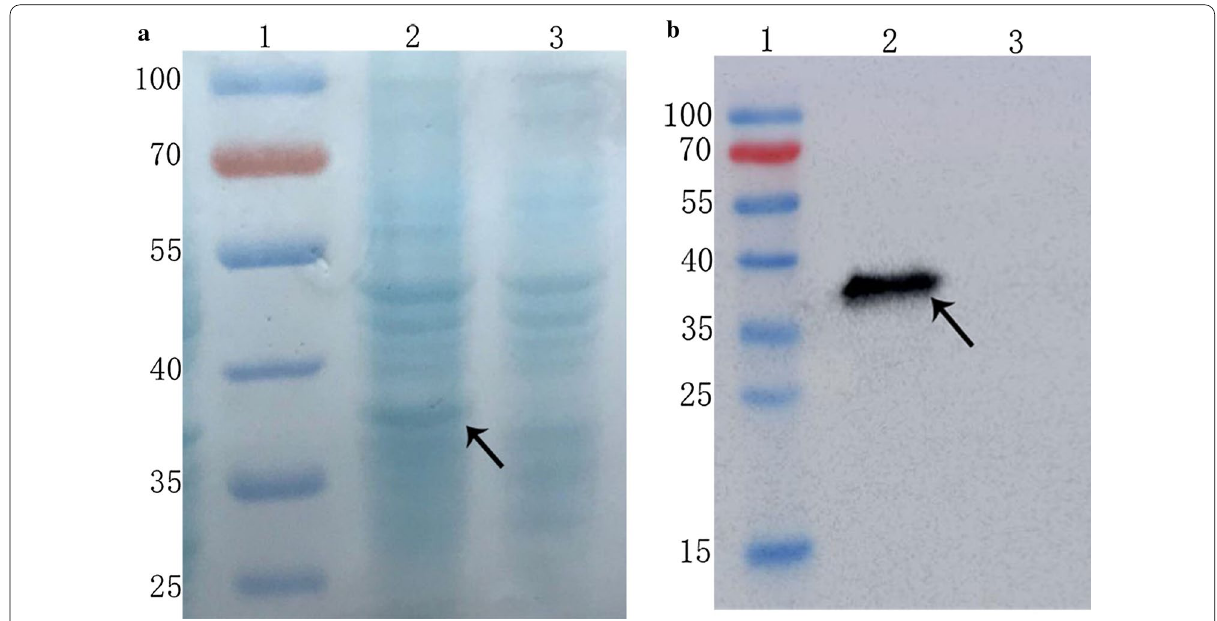
Fig. 3 SDS-PAGE and Western blot of recombinant mutant Staphylococcal enterotoxin B in B. subtilis spores. a SDS-PAGE analysis of coat proteins extracted from recombinant mSEB spores. Lane 1, prestained protein marker; Lane 2, mSEB spore coat proteins; lane 3, CotC spore coat proteins;